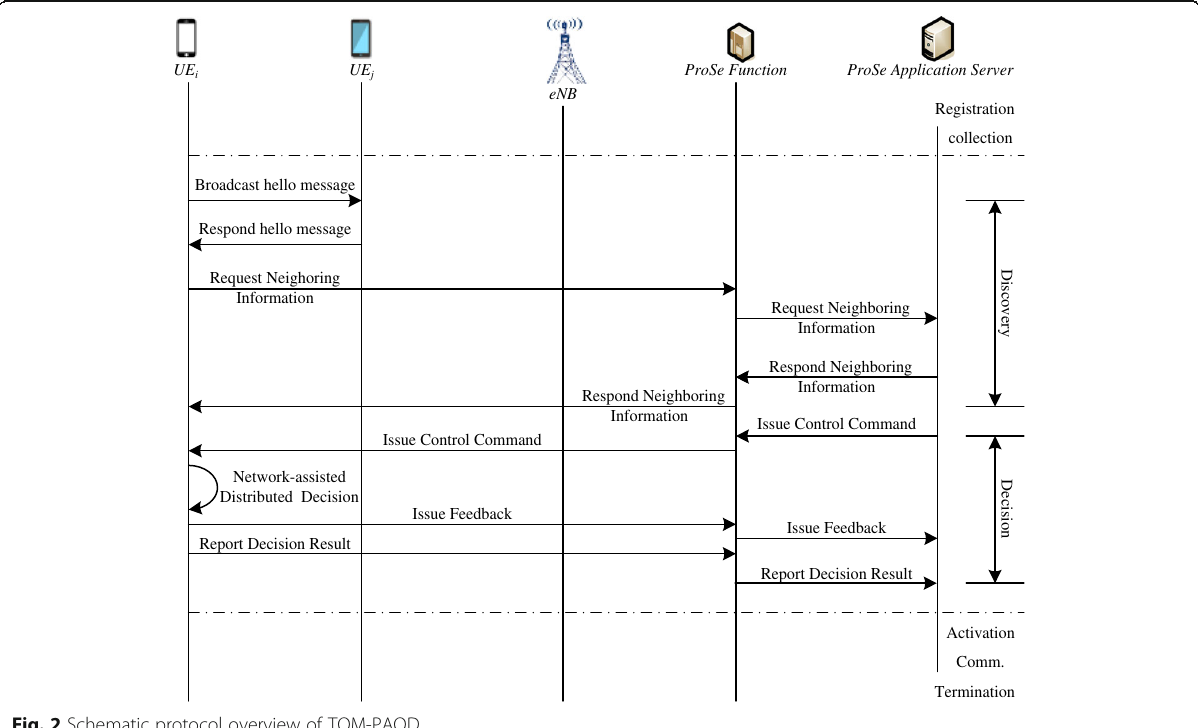
Fig. 2 Schematic protocol overview of